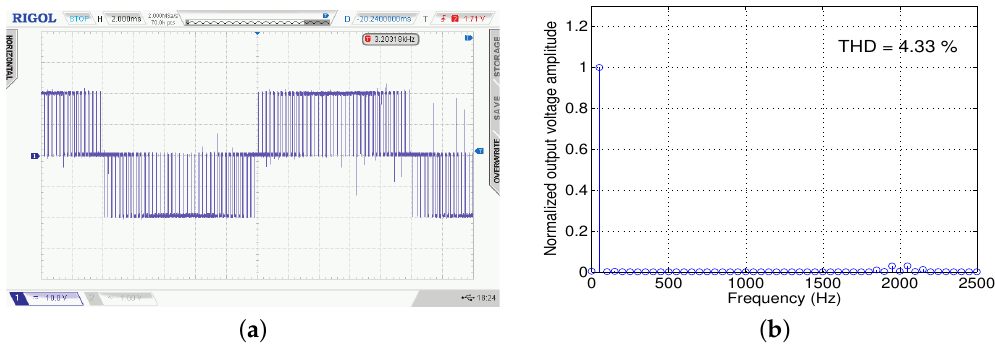
Figure 11. ( a ) Inverter output voltage with SPWM at m I = 1 and ( b ) Its frequency spectrum.